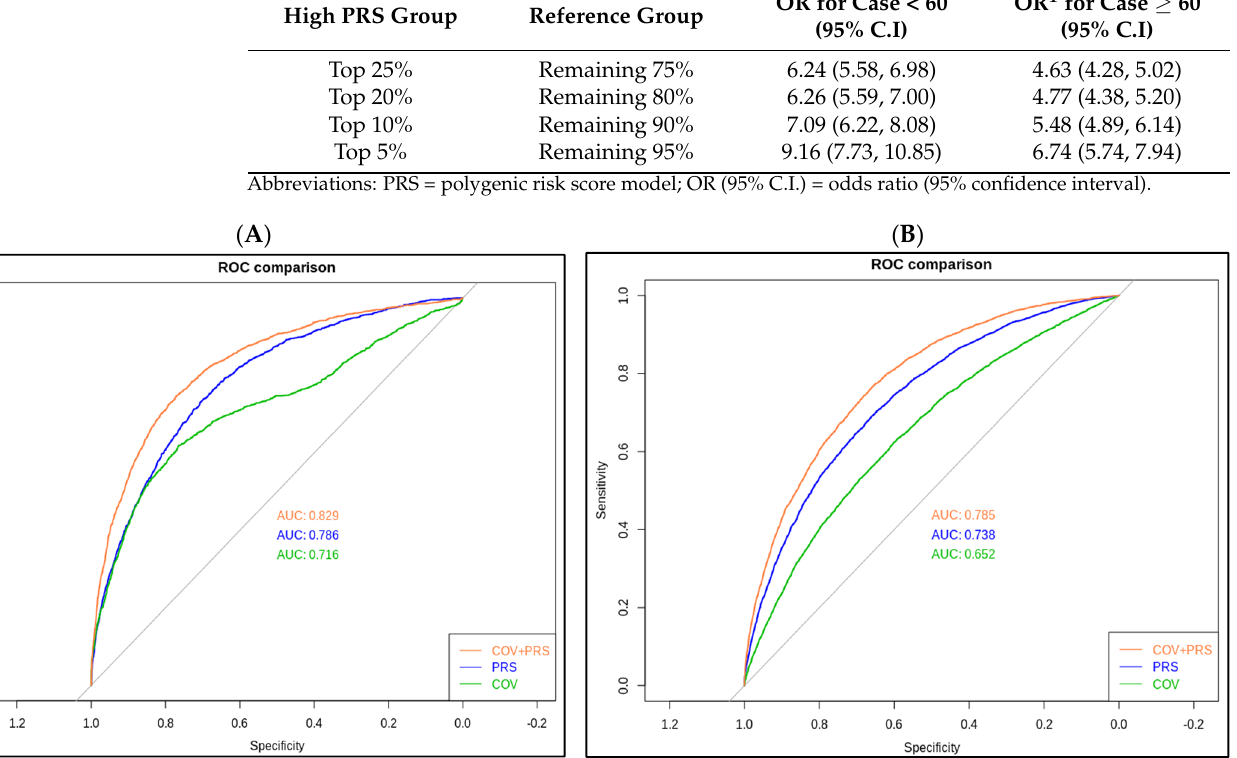
Table 5. Risk of high PRS groups for development of cataracts for younger cases (<60) and older cases ( ≥ 60).